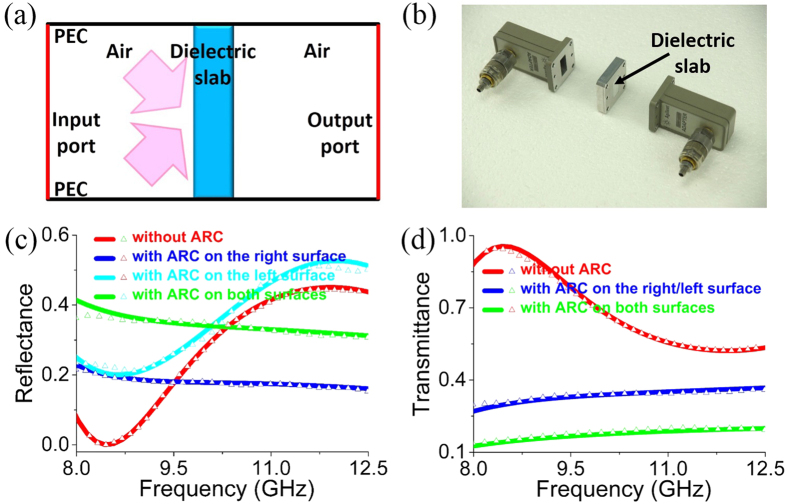
Experiments in waveguides for oblique incidence.(a) Illustration and (b) photo of the experimental setup of rectangular waveguides. Simulated (solid lines) and measured (triangular symbols) (c) reflectance and (d) transmittance in the waveguide with TE10 modes. The relevant parameters of the dielectric slab are ε1 = 4 + 0.03i and d1 = 9.6 mm. The conductive film has a sheet resistance of Rs = 370 Ω and a conducting layer thickness of 2.6 μm.